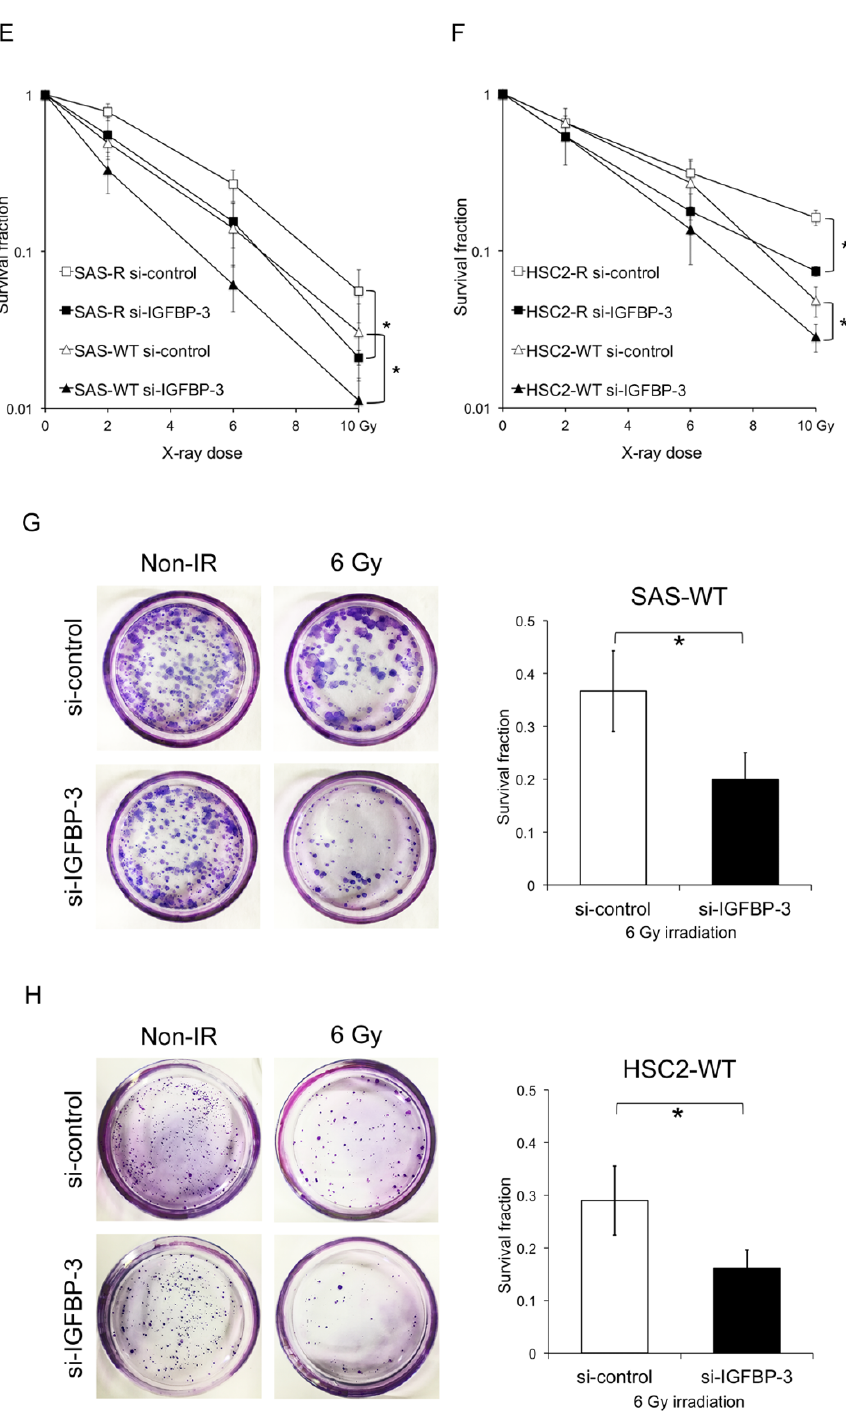
Figure 2. IGFBP-3 confers resistance to radiation in OSCC cells. ( A , B ) IGFBP-3 mRNA and protein expression levels in clinically relevant radioresistant (CRR) cells and parental cells. ( C , D ) IGFBP-3 mRNA and protein levels in SAS and HSC-2 cells after transfection with IGFBP-3 or control siRNA. Total RNA and whole-cell lysates were used for qRT-PCR ( A , C ) and Western blot analysis ( B , D ), respectively. ( E , F ) CRR and parental cells were transfected with IGFBP-3 or control siRNA and exposed to an X-ray dose of 0, 2, 6, and 10 Gy; the surviving fraction was then evaluated using a modified high-density survival (HDS) assay. ( G , H ) SAS and HSC-2 cells transfected with IGFBP-3 siRNA or control were exposed to 6 Gy, and then the surviving fraction was evaluated by clonogenic assays. The results are shown as the means ± SD of three independent experiments. * p < 0.05. ** p < 0.01.